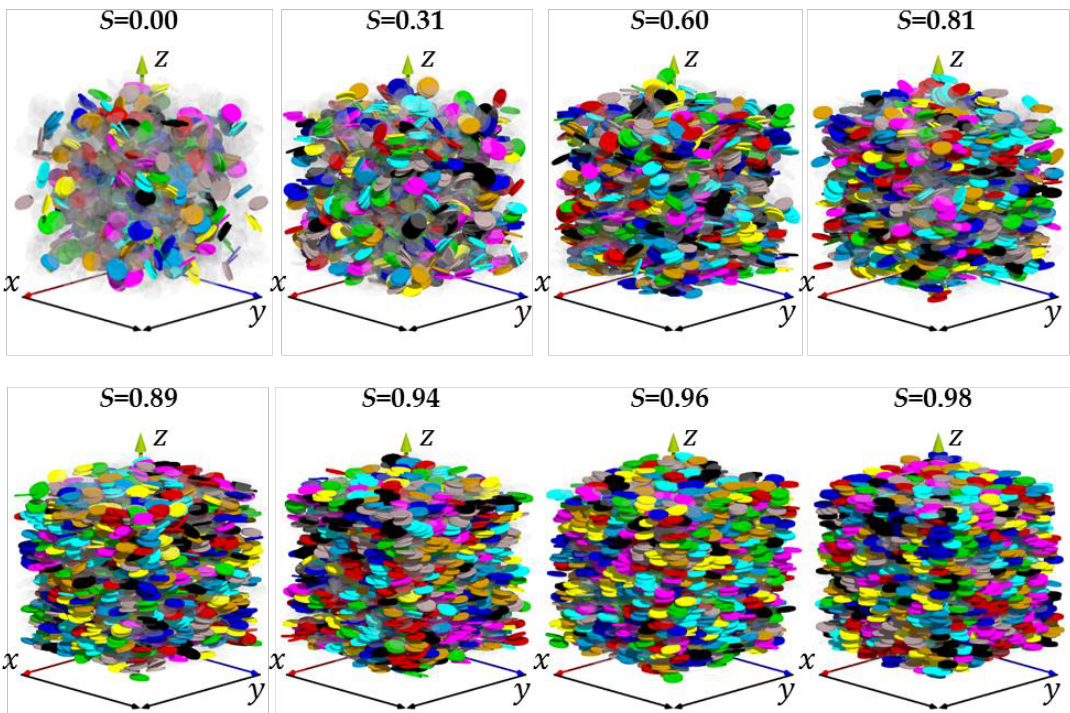
Figure 6. Illustration of particle aggregation for selected simulated packings. A given colour is assigned to all particles from the same aggregate. Translucent particles correspond to disks not involved in aggregates.